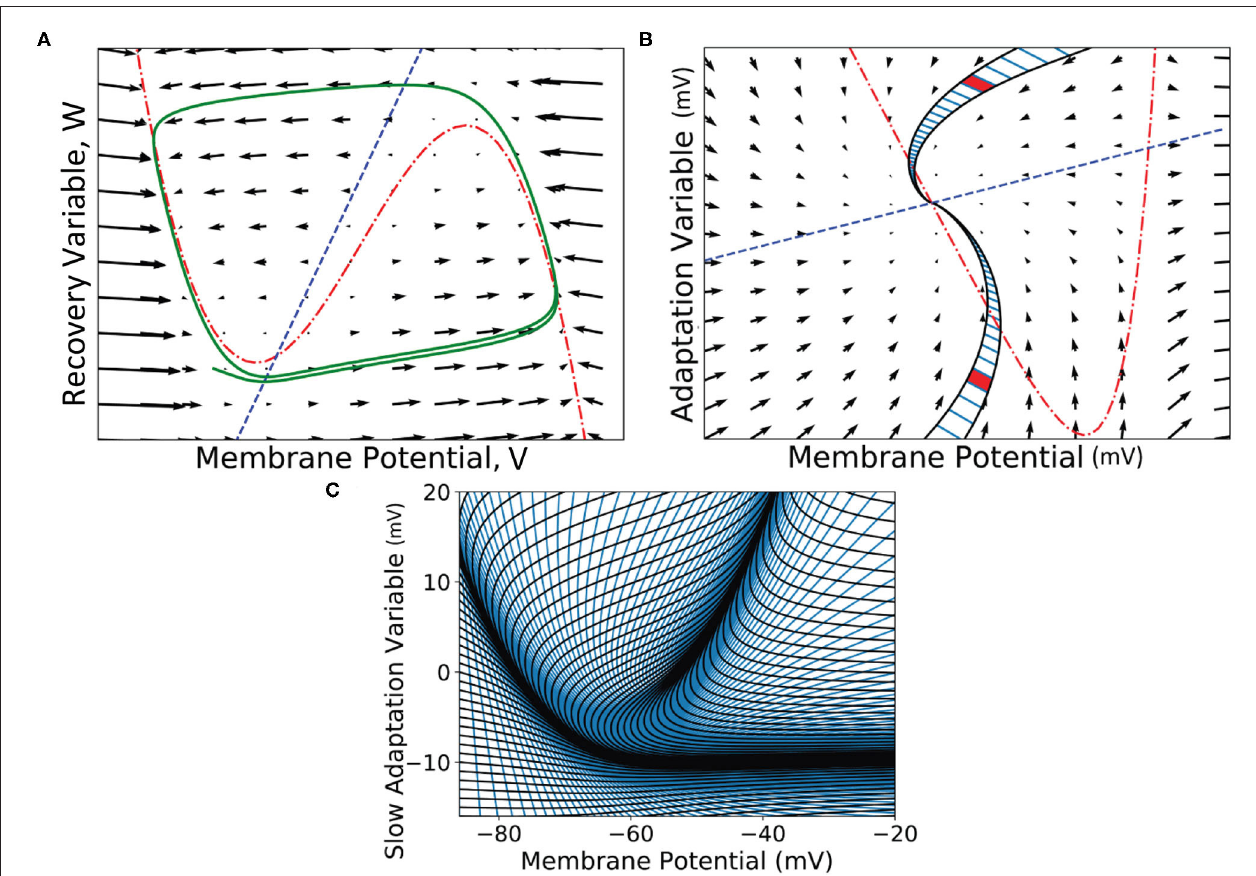
FIGURE 8 | (A) A vector field of the FitzHugh-Nagumo neuron model (FitzHugh, 1961). Arrows show the direction of motion of states through the field according to the dynamics of the model. The red broken dashed nullcline indicates where the change in V is zero. The blue dashed nullcline indicates where the change in W is zero. The green solid line shows a potential path (trajectory) of a neuron in the state space. (B) A vector field for the adaptive exponential integrate and fire neuron model (Brette and Gerstner, 2005). Two strips are shown which follow the dynamics of the model and approach the stationary point where the nullclines cross. A strip is constructed between two trajectories in state space. Each time step of the two trajectories is used to segment the strip into cells. Because the strips approach a stationary point, they get thinner as the trajectories converge to the same point and cells get closer together as the distance in state space travelled reduces per time step (neurons slow down as they approach a stationary point). Per time step, probability mass is shifted from one cell to the next along the strip. (C) The state space of the Izhikevich simple neuron model ( Izhikevich, 2003) which has been fully discretised into strips and